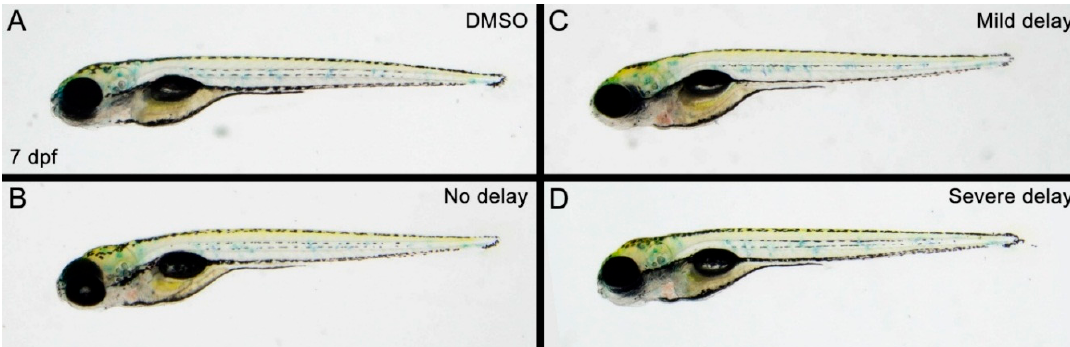
Figure 2. Zebrafish with propoxur-induced delays undergo physical recovery to obtain the general appearance of control zebrafish by 7 days postfertilization: ( A ) DMSO-treated control group; ( B ) propoxur-treated group exhibiting phenotype of no delay; ( C ) propoxur-treated group exhibiting phenotype of mild delay; and ( D ) propoxur-treated group exhibiting phenotype of severe delay. 3.2. Zebrafish with the Severely Delayed Phenotypes Develop a Photophobic Response to Light Leading